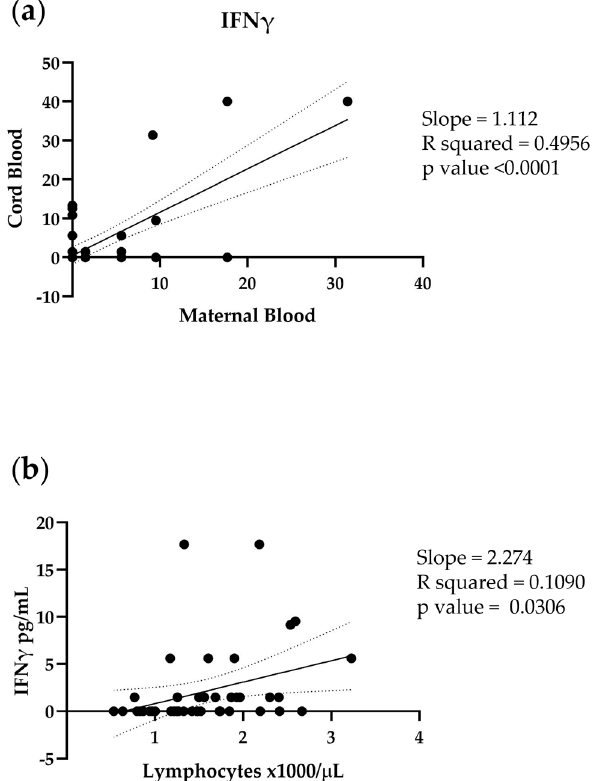
Figure 3. Simple linear regression of ( a ) IFN- γ levels (pg/mL) in maternal blood and cord blood; ( b ) lymphocyte count (1000/ µ L) and IFN- γ levels (pg/mL) in maternal blood. Each subject is represented on a scatter plot.